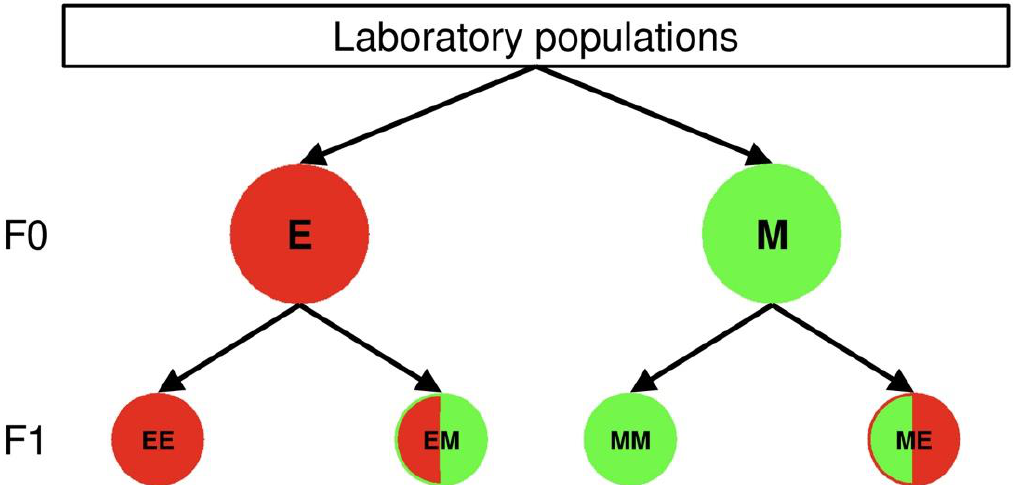
Figure 1. Rearing conditions of the parental (F0) and offspring generation (F1) during juvenile development. Parental individuals derived from females of the lab populations and raised under extreme (E, red F0 cycle) or mild heat waves (M, green F0 cycle) until adulthood. The parental females were then allowed to deposit the offspring eggs, which were either exposed to extreme or mild heat wave conditions for their whole juvenile development. The first and second upper case letters in the F1 cycles are indicating the parental and offspring heat wave conditions during juvenile development, respectively. The colors of the F1 cycles indicate, whether parental heat wave conditions are matching offspring conditions (uniformly colored cycles) or not (bicolored cycles). In the latter case the colors in the left and right semi-cycles indicate the parental and offspring heat wave conditions, respectively. The following combinations of the parental and offspring heat wave conditions were evaluated: (1) parents and offspring developed under extreme heat waves (EE, uniformly red colored), (2) parents developed under extreme heat waves, offspring under mild heat waves (EM, red and green colored), (3) parents and offspring developed under mild heat waves (MM, uniformly green colored), (4) parents developed under mild heat waves, offspring under extreme heat waves (ME, green and red colored).